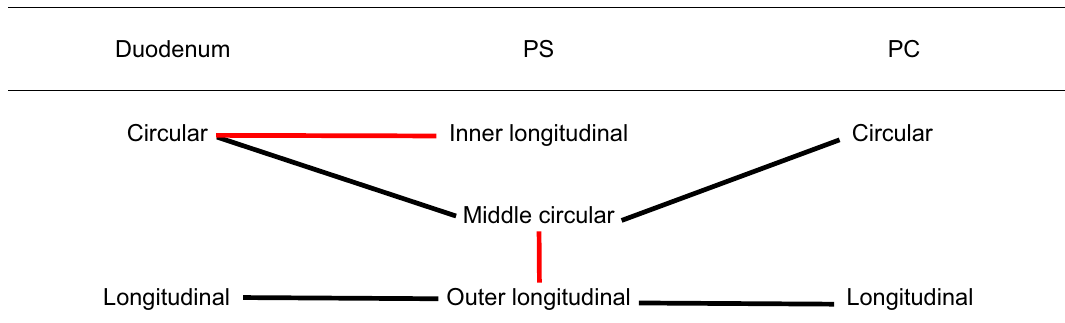
Longitudinal Outer longitudinal Table 1. Changes and connections of the muscle layers between the pyloric canal (PC) and duodenum. The PC has two muscle layers: the inner circular and outer longitudinal muscle bundles. The pyloric sphincter (PS) has three muscle layers: inner longitudinal, middle circular, and outer longitudinal bundles. The duodenum has two muscle layers: inner circular and outer longitudinal bundles. Some of the outer longitudinal bundles of the PS were connected to the middle circular bundles of the PS. The inner longitudinal bundles of the PS were connected to the circular bundles of the duodenum. Red lines indicate connections between the longitudinal and circular bundles. Black lines indicate continuous longitudinal or circular fibers between the PC and the PS and between the PS and duodenum.